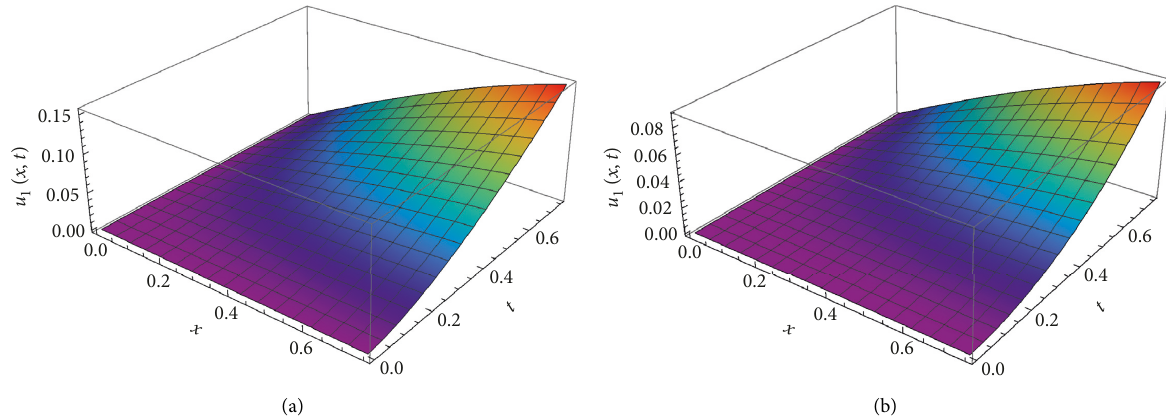
Figure 1: The graphs of the first-order iterative solution u ( x, t ) for (25) through various values of x,t at α � 0 . 5 , 1, respectively. (a) The 1 graph of first-order iterative solution for (25) through various values of x,t at α � 0 . 5. (b) The graph of the first-order iterative solution for (25) through various values of x,t at α � 1.